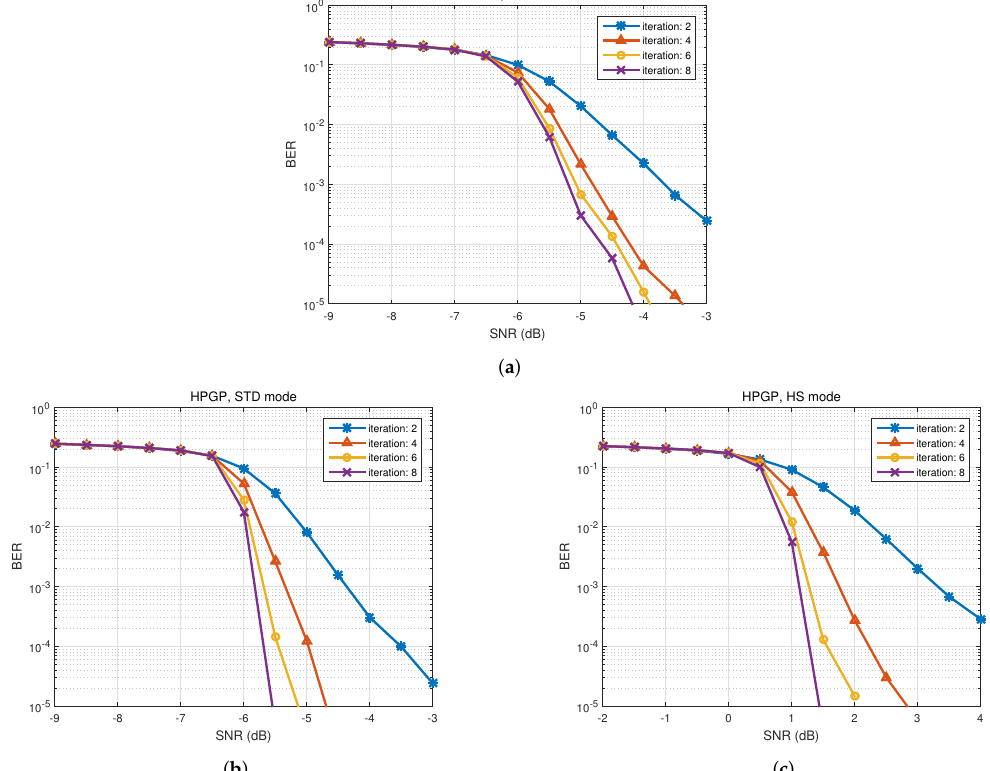
Figure 18. BER results for HPGP: ( a ) MINI mode; ( b ) STD mode; and ( c ) HS